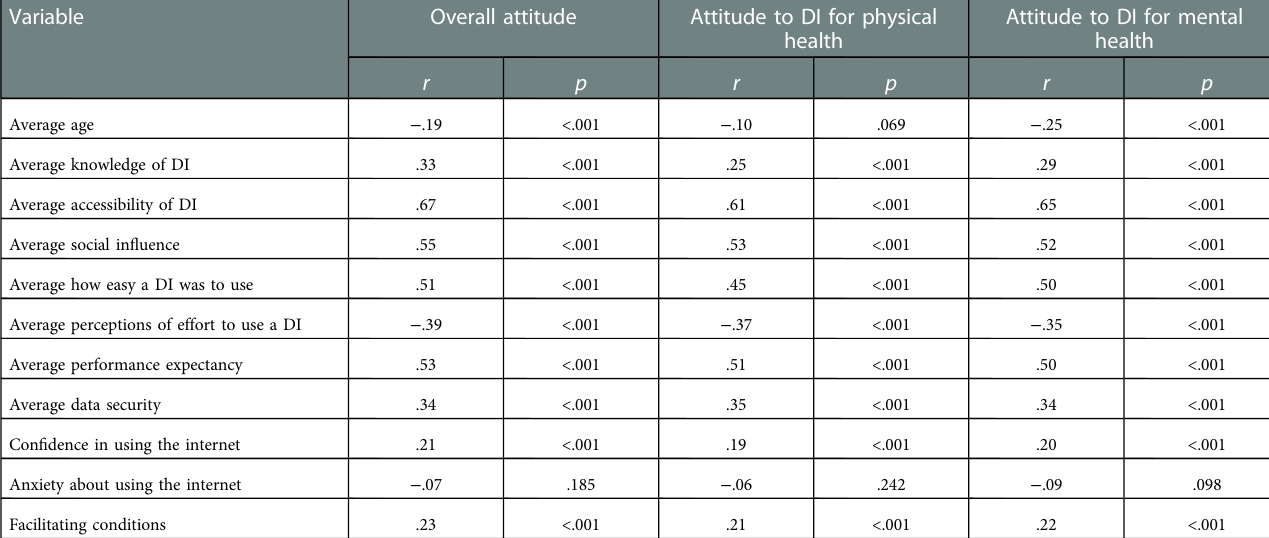
TABLE 5 Pearsons correlations between factors shaping overall attitude, attitude towards DI for physical health (PH) and attitude towards DI for mental health